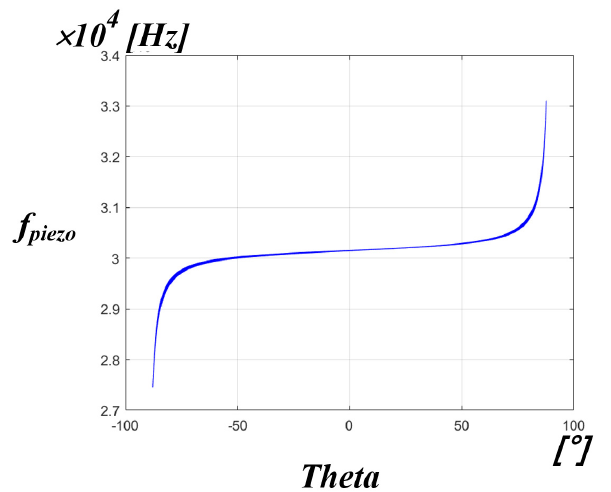
Figure 17. Simulation result of the correlation between the f piezo and the inverter phase difference theta.